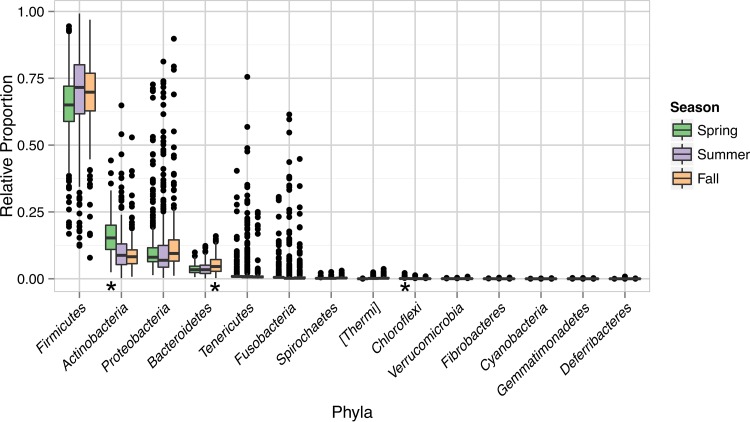
Relative proportions of the bacterial phyla present in raw tanker milk. The relative proportions of OTU counts rarefied at 15,000 sequences per sample are shown. A star beneath a box plot indicates a significant positive correlation by analysis of rarefied data with MaAslin (correlation coefficient, >0; q value, <0.05) and CSS-normalized data with LefSe (LDA effect size, >2; P value, <0.05). “Thermi” is a taxonomic assignment based on genome trees and is not officially recognized (i.e., Bergey's Manual of Systematic Bacteriology).